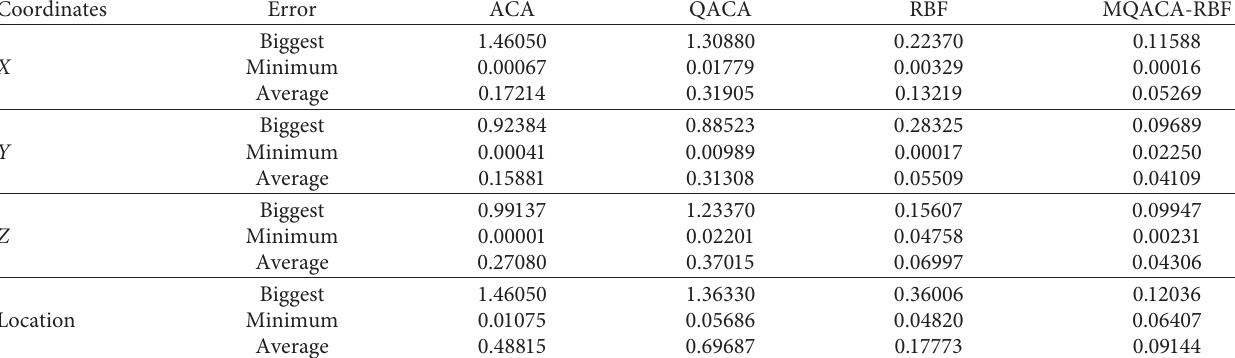
Table 4: Comparison of coordinate and position errors